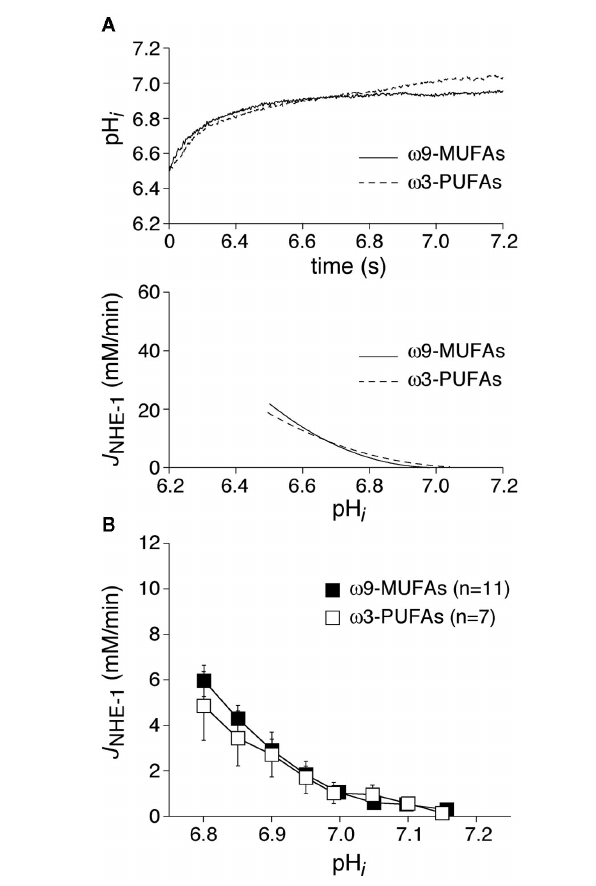
FIGURE 3 | (A) Typical examples of pH i recovery after an ammonium prepulse (top) and the calculated J NHE-1 (bottom) in an ω 9-MUFA and ω 3-PUFA myocyte isolated from rabbit which underwent volume- and NHE-1 in pressure-overload. (B) Average J NHE-1 in myocytes isolated from ω 9-MUFA and ω 3-PUFA fed rabbits with volume- and pressure-overload. * P <